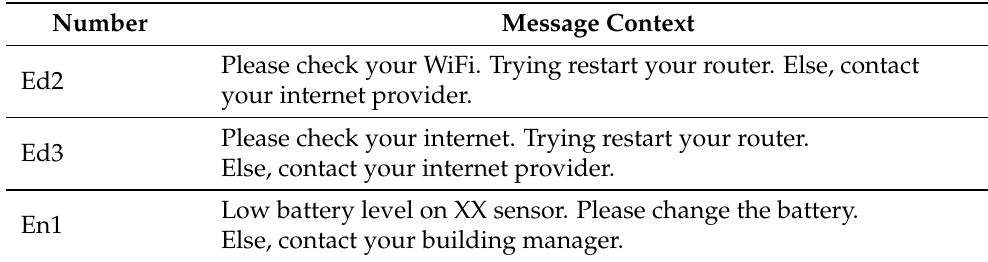
Table 6. Respective messages per IoT